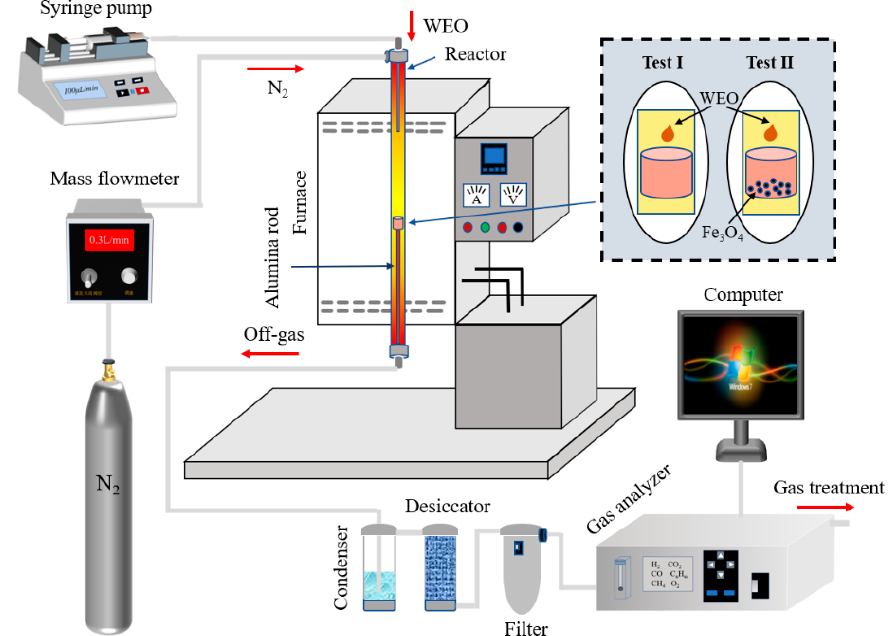
Figure 1. Experimental device.